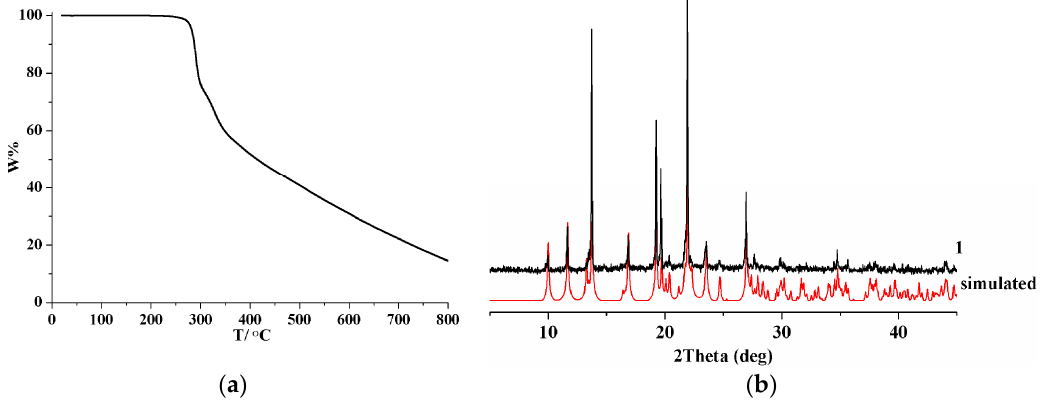
Figure 2. Thermogravimetric analysis (TGA) curve ( a ) and powder X-ray diffraction (PXRD) patterns ( b ) of 1 .